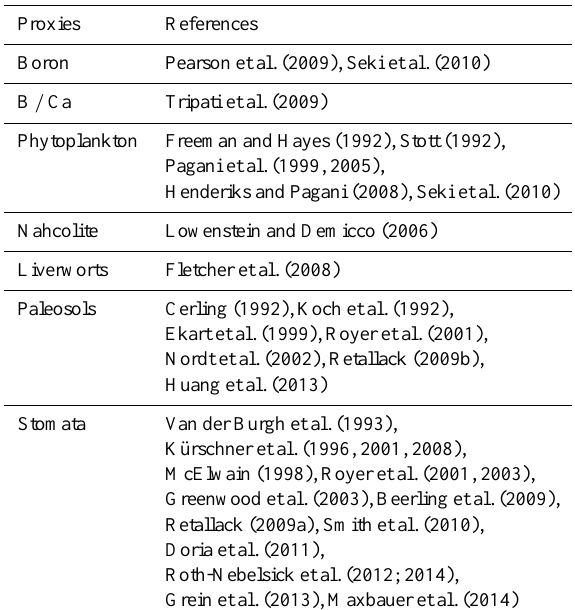
Table 9. p CO 2 estimates proxies and corresponding